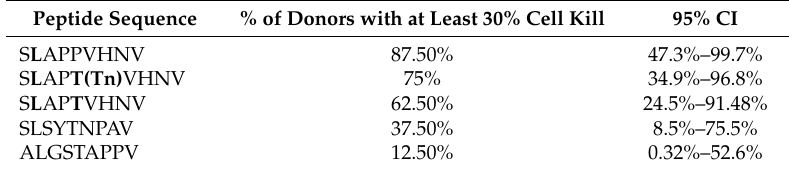
Table 2. Predicted percent of donors that will respond to MUC1-peptide immunization. Peptide